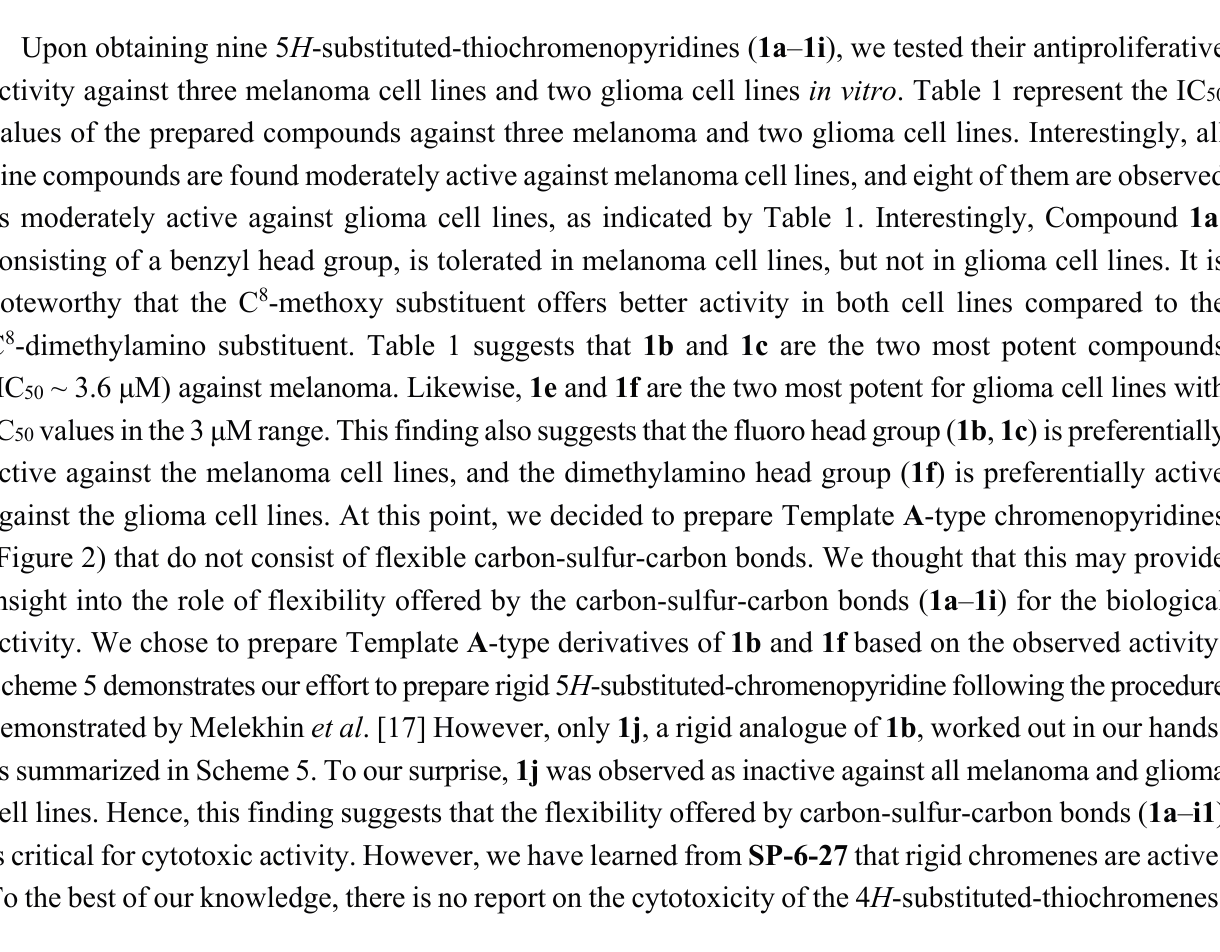
Table 1 . Anti-proliferative activity of prepared chromenopyridine and chromene